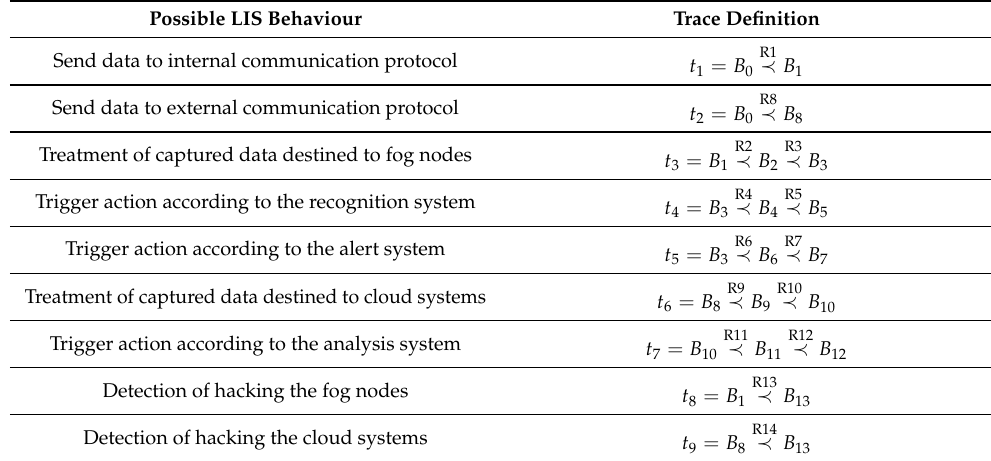
Table 6. Possible traces modelling the LIS behaviour. Possible LIS Behaviour Trace